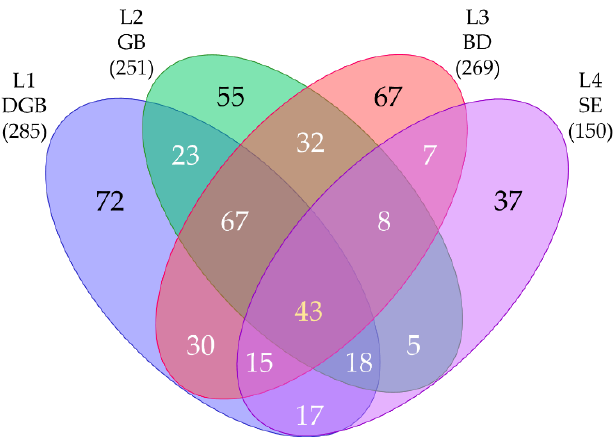
Figure 4. Relative abundance of the metabarcoding fungal diversity at ( a ) phylum, ( b ) family and ( c ) genus level per sample.